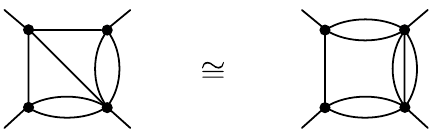
Figure 16: The trivial “acnode" graph (left) and the accumulation graph (right) have the same Landau curve. Note that the acnode graph has two trivial triangles (top right and bottom left vertices satisfy (36), or equivalently (38)). No obvious graph- theoretic operation relates the graphs. It is also not clear to us how the Landau equations of the two are related, except by looking at the α -positive solutions.